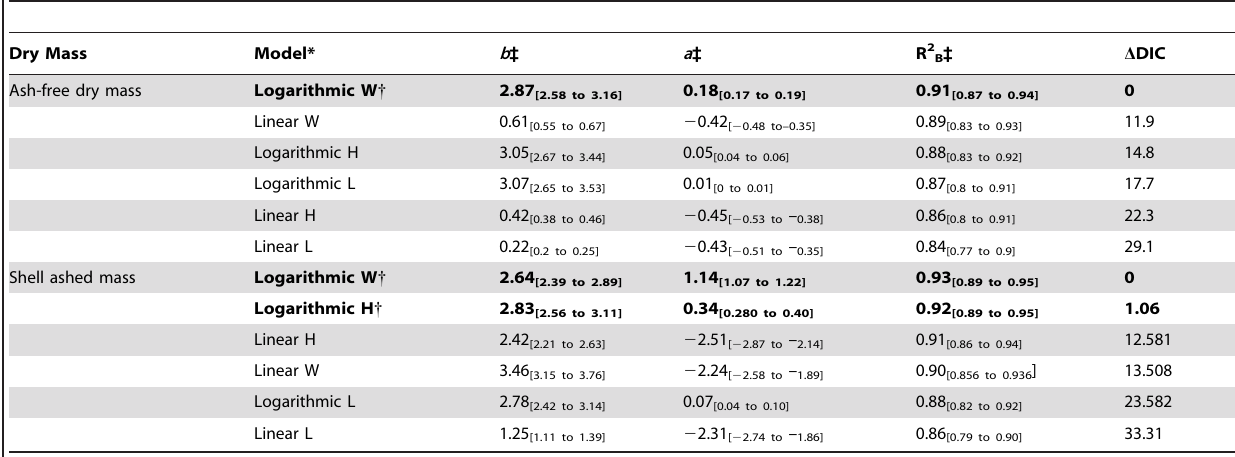
Table 3. Relationships between shell dimensions and tissue dry mass for 50 artificially propagated juvenile Lampsilis siliquoidea mussels.